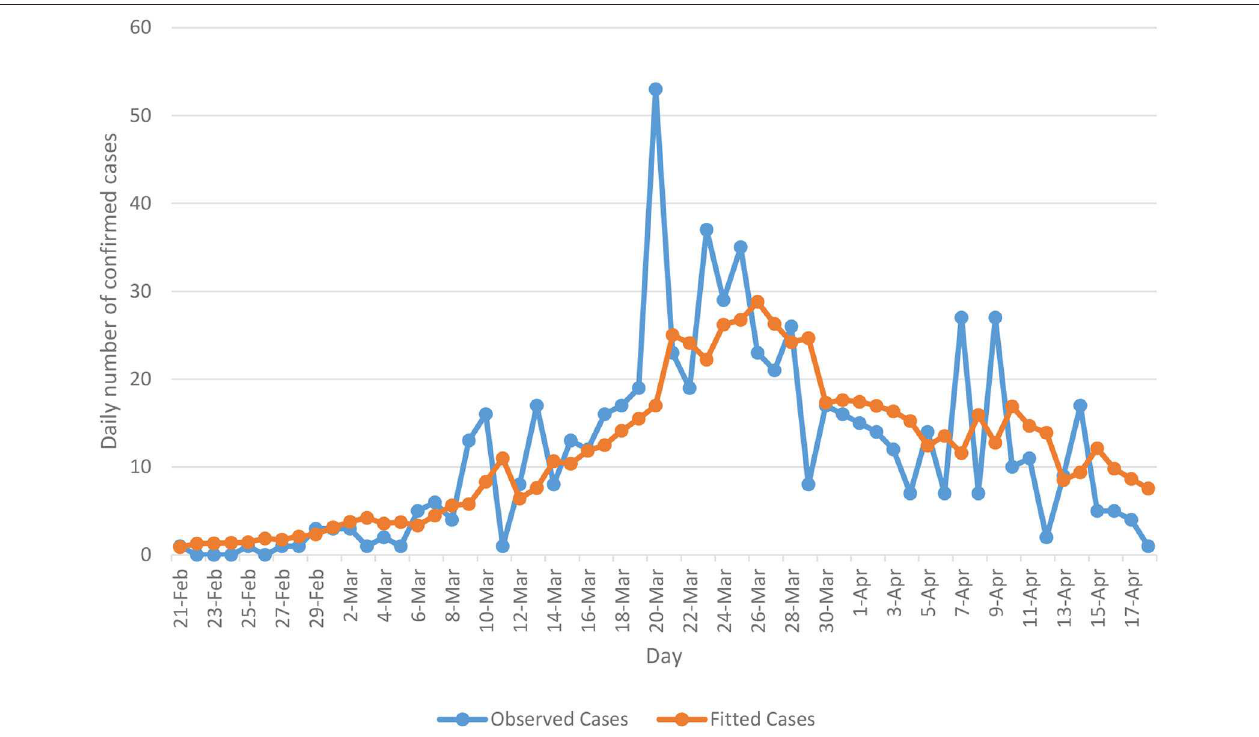
FIGURE 1 | Actual (blue line) and fitted (orange line) cases based on the Poisson autoregressive model (Model 2).